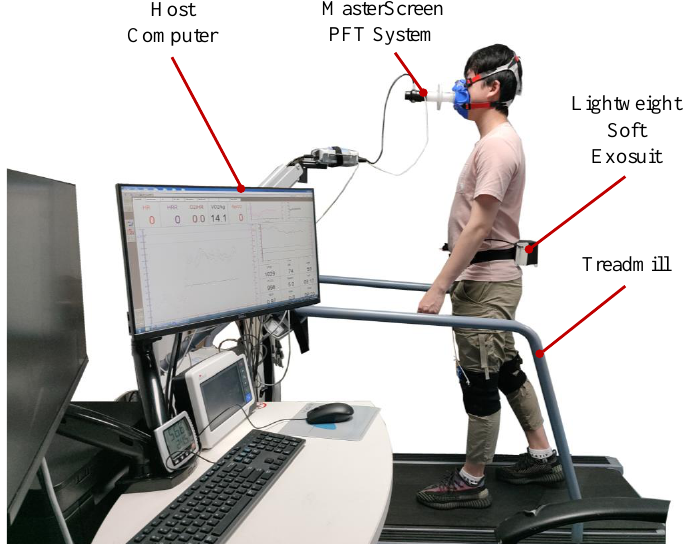
Figure 7. Evaluation experiment of lightweight soft exosuit with MasterScreen PFT System. Subjects wear the lightweight soft exosuit and measure metabolic